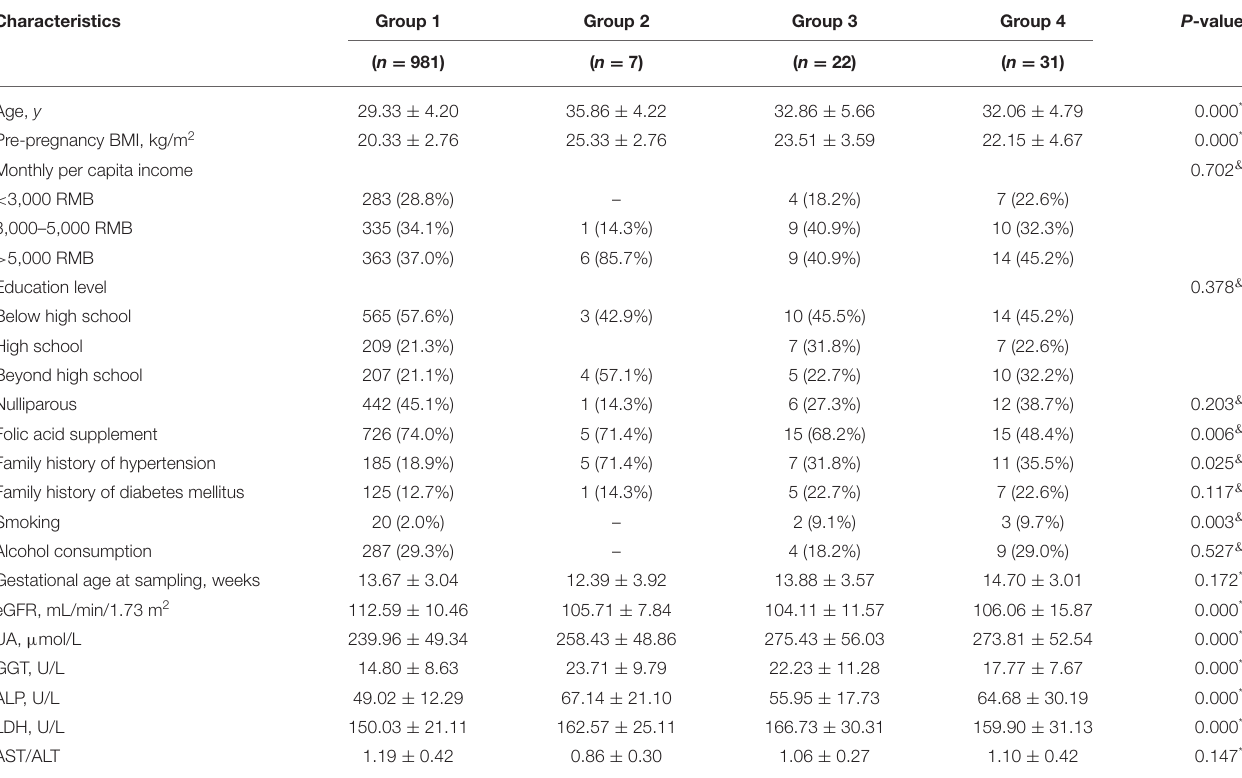
TABLE 5 | Baseline characteristics of normal pregnancy (group 1), chronic hypertension (group 2), gestation hypertension (group 3), and preeclampsia (group 4). Characteristics